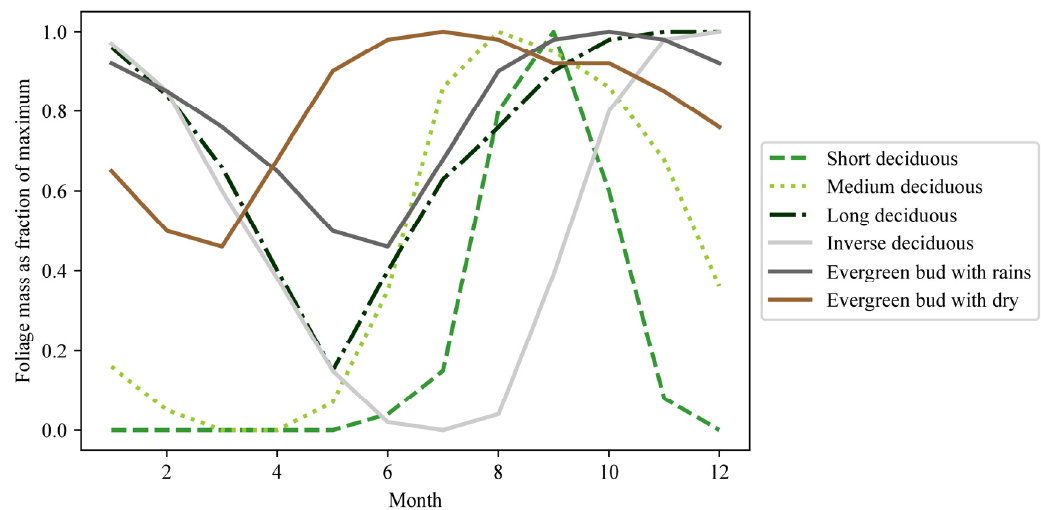
Figure 2. Seasonal distribution of leaf mass depending on the phenological type of woody plants in the Sahel [8]. The inverse deciduous type represents Faidherbia albida trees.